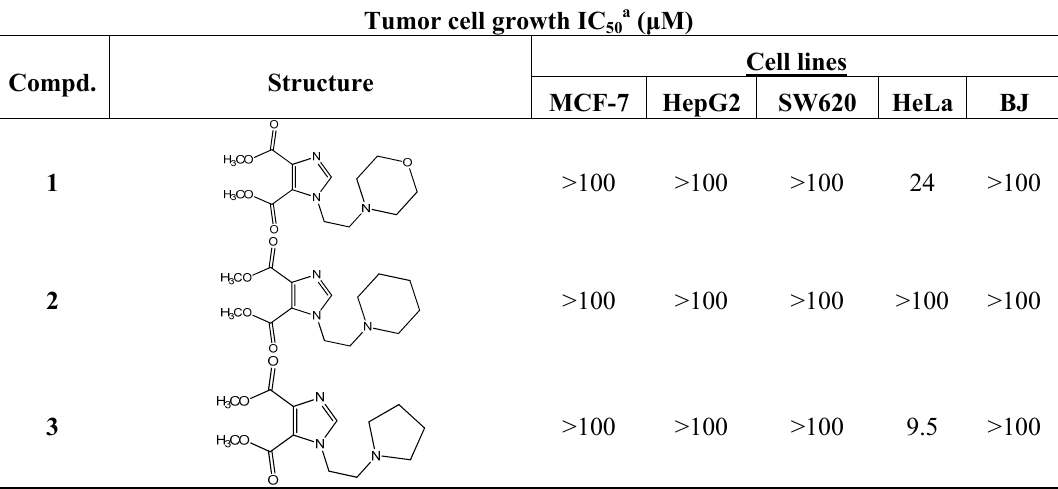
Table 1. Inhibitory effects of compounds 1 – 12 on the growth of malignant tumor cell lines in comparison with their effect on normal human skin fibroblasts